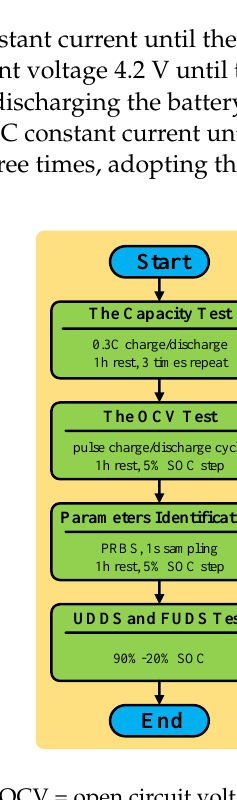
Figure 3. Battery cell test scheme. OCV = open circuit voltage; SOC = state of charge; PRBS = pseudo random binary sequence; UDDS = Urban Dynamometer Driving Schedule; FUDS = Federal Urban Driving